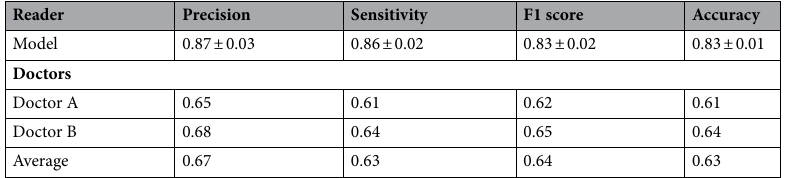
Table 4. Comparison of the performance results between the neurosurgeons in visual observation and machine-learning model. F1 score F-score or F-measure is a measure of a test’s accuracy which is calculated from the precision and recall of the test. Mean ± standard